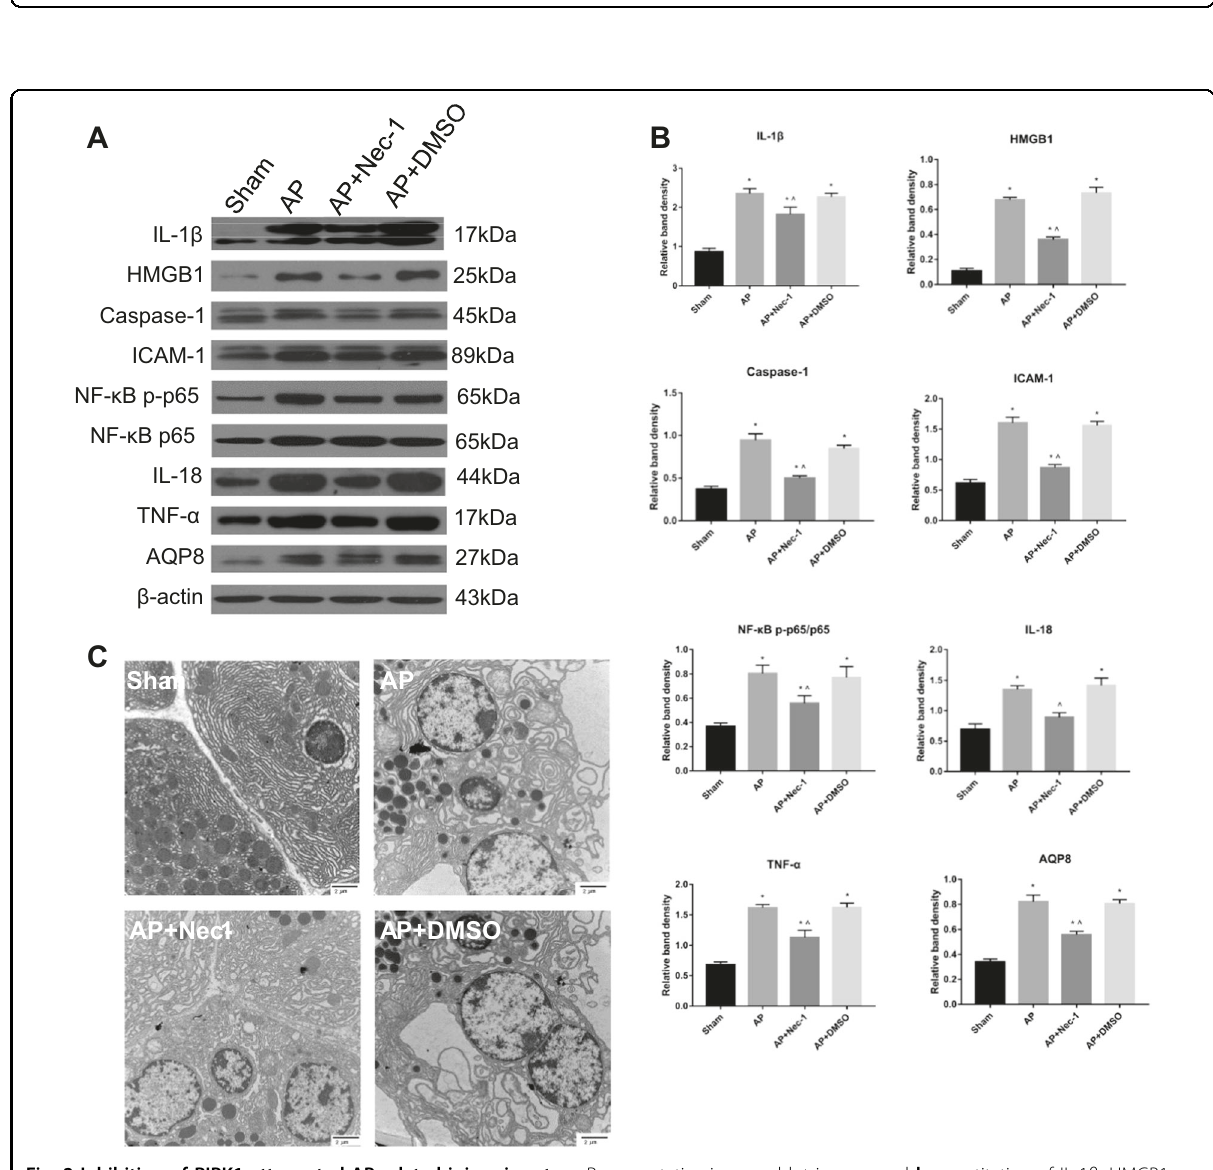
Fig. 2 Inhibition of RIPK1 attenuated AP-related injury in rats. a Representative immunoblot images and b quantitation of IL-1 β , HMGB1, Caspase-1, ICAM-1, NF- κ B p-p65/p65, IL-18, TNF- α , and AQP8 expression in pancreatic tissues harvested from the rats described above. β -Actin was used as the protein loading control. c Representative TEM images of pancreatic tissues from the rats described in Fig. 1a; bar: 2 μ m. The data are the means ± S.Ds. ( n = 3). * P < 0.05 versus sham, ^ P < 0.05 versus